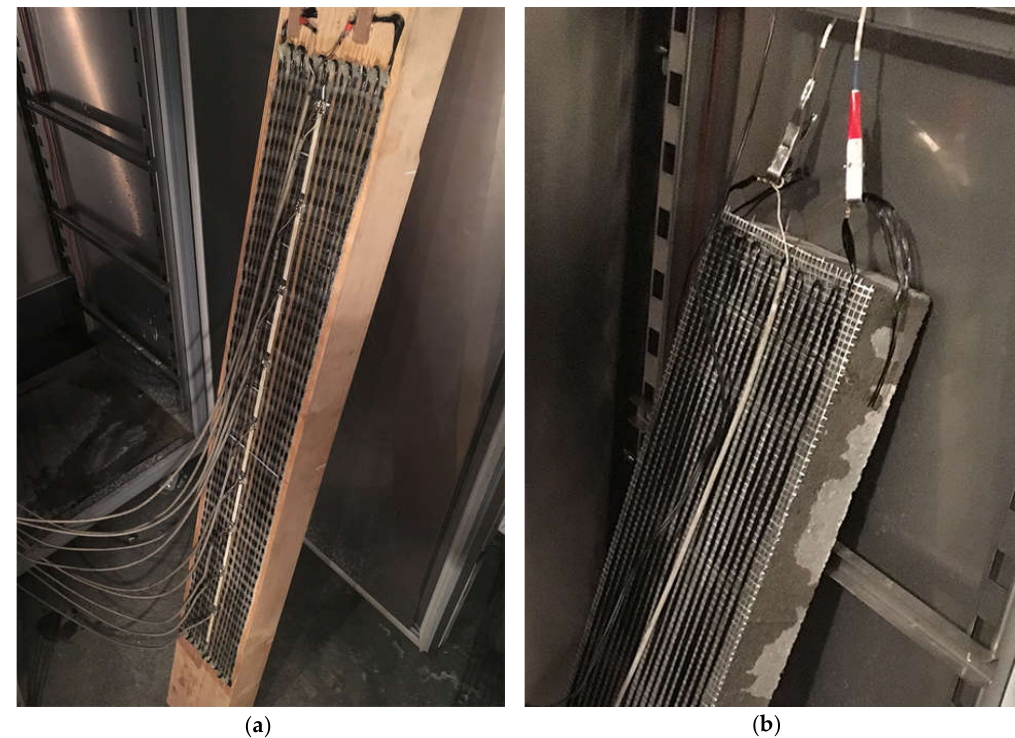
Figure 3. Samples inside the climate chamber during the test: ( a ) second generation of the sensor and timber sample; ( b ) third generation of the sensor and concrete sample.